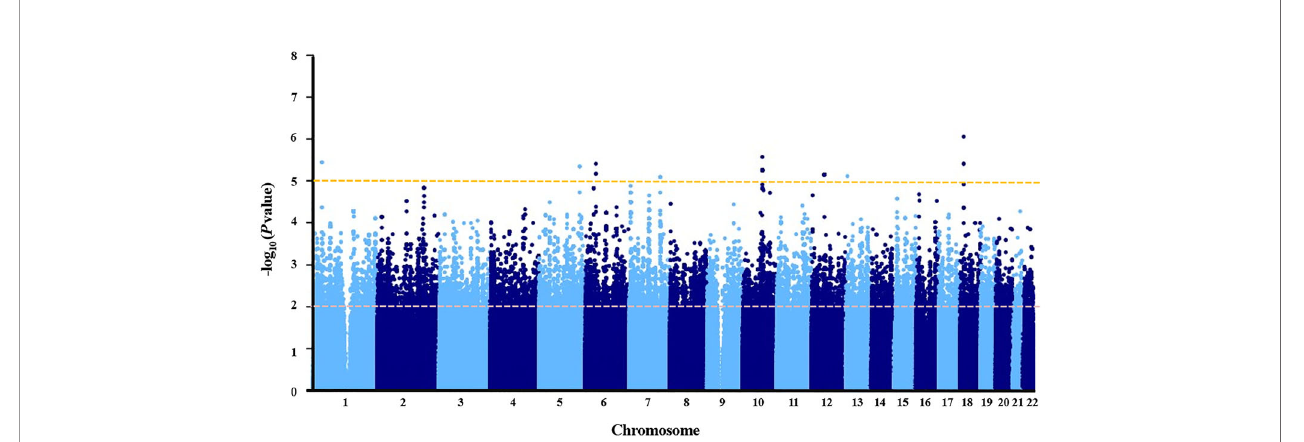
FIGURE 2 | Manhattan plot of negative log of corresponding p ‐ values from genome ‐ wide association study.